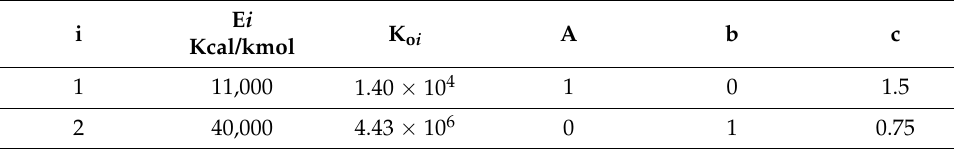
Table 2. Reaction kinetic values of the Claus